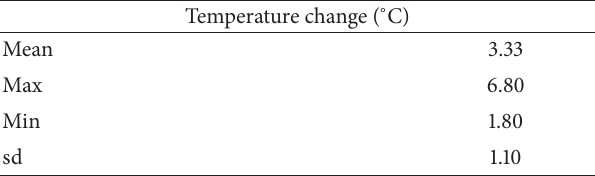
Table 1: Descriptive statistics of the outcomes of thermocouple